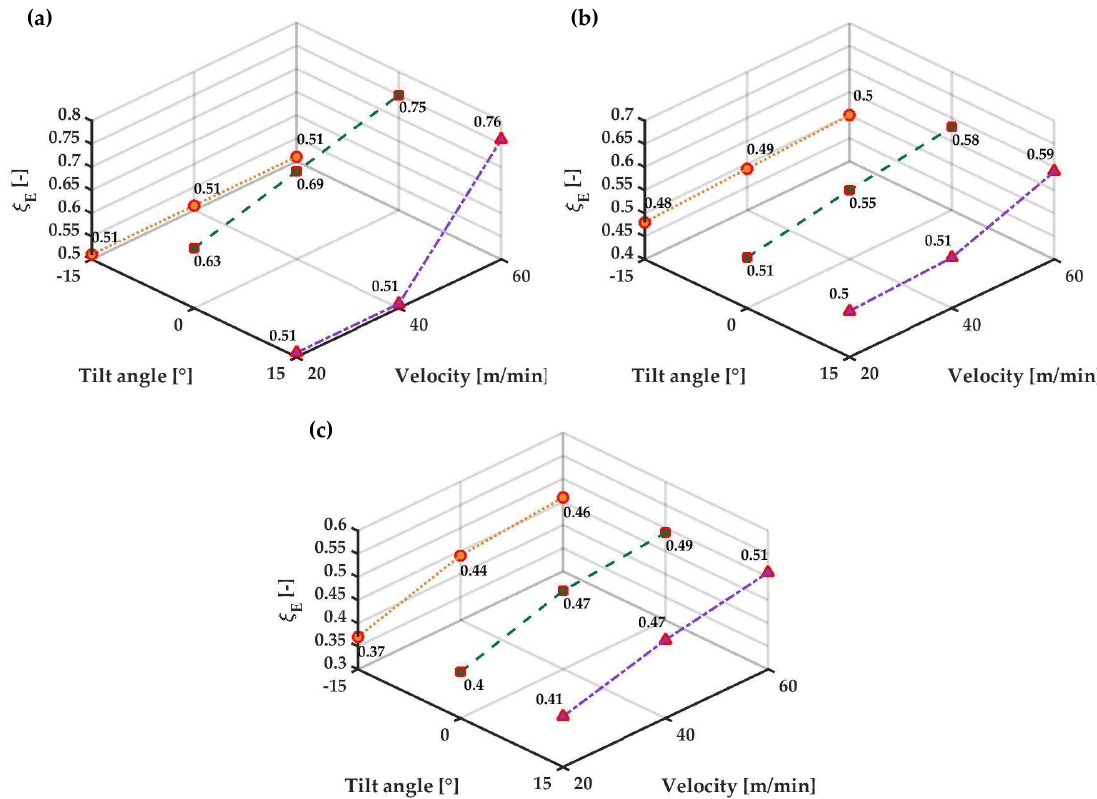
Figure 13. Energy effectiveness coefficient at section β for AC mass flow inlet ( a ) 3%; ( b ) 5%; ( c ) 7%.